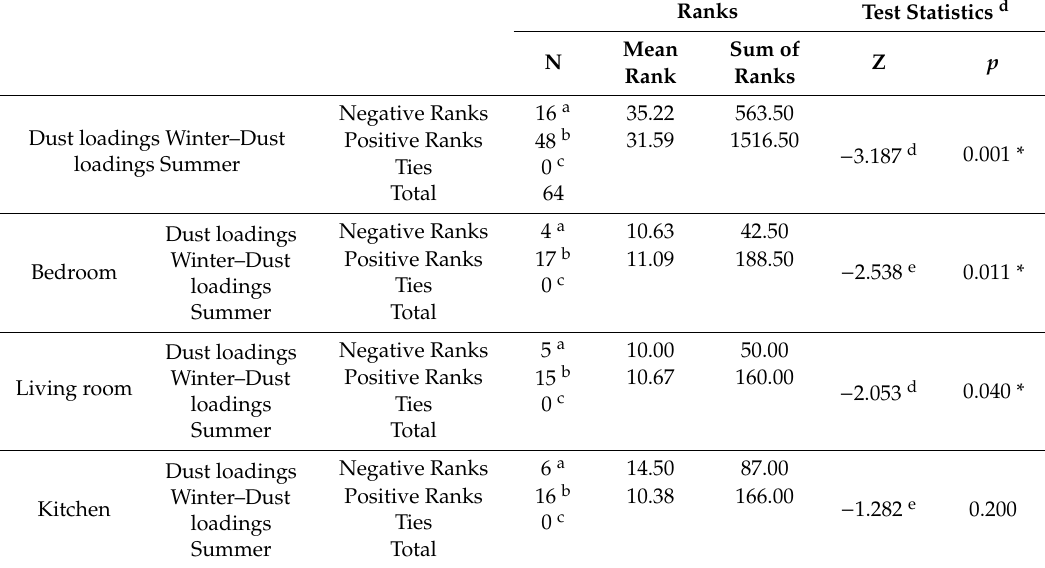
Table 4. Comparison between dust loads ( µ g / cm 2 / day) in summer and winter.